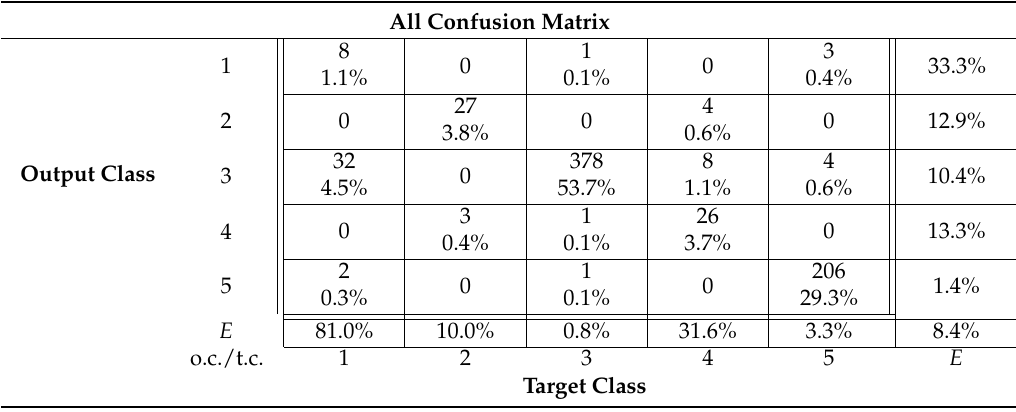
Table 1. Classification of all input vectors in all confusion matrix.